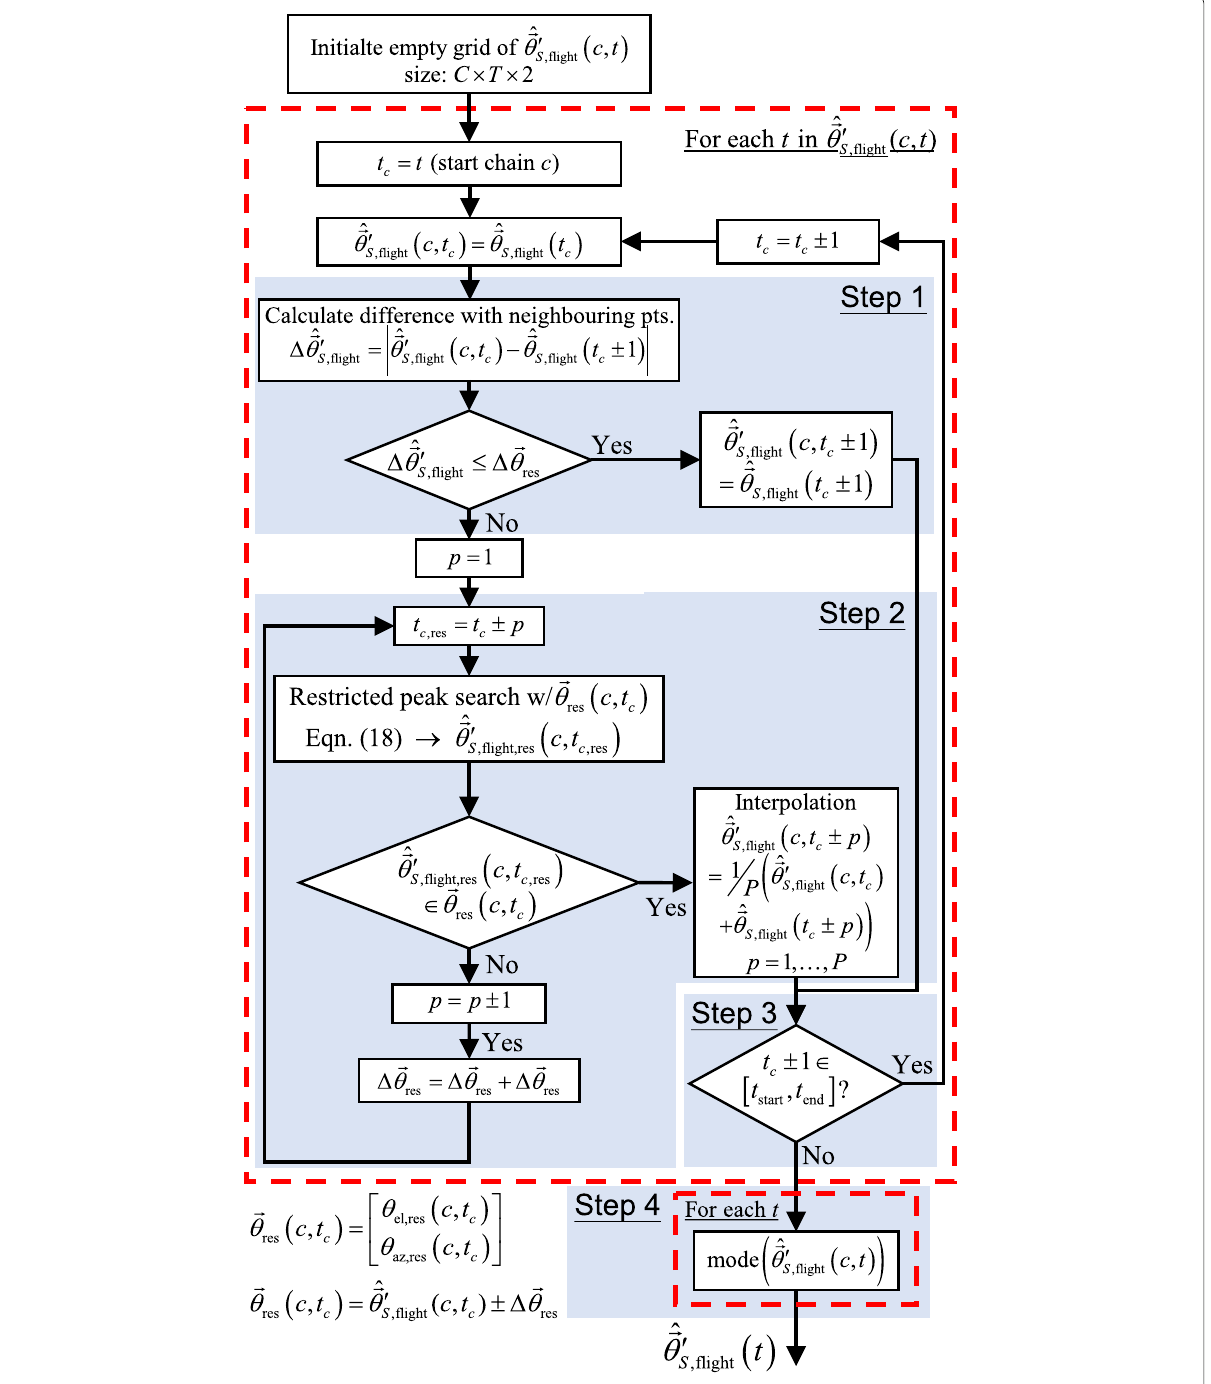
Fig. 4 Flowchart of the angular spectral range restricted peak search and link algorithm. The steps highlighted correspond to the steps described in Section